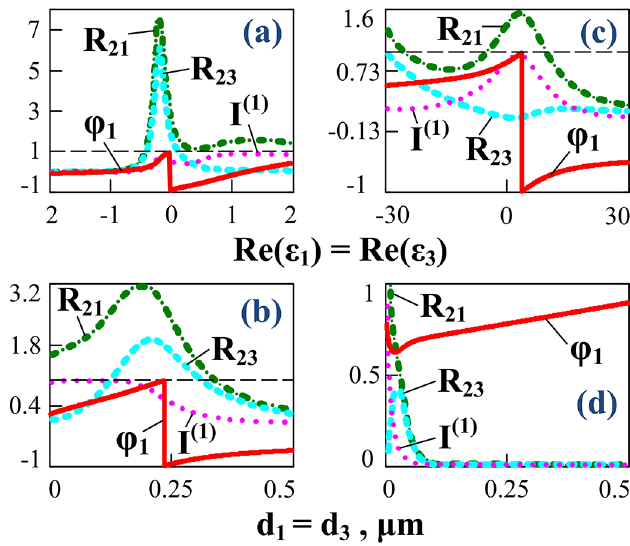
Fig. 10. Dependences of quantities ’ 1 , R 21 , R 23 , I (1) on parameters e 0 (a, c), d 1,3 (b, d) for various materials of layers 1 ; 3 ¼ 0 : 01 (a, b), 0.5 (c, d); 1, 3. The values of parameters are: e 00 1 ; 3 e 0 ¼ 0 : 01 (b), (cid:1) 13 (d); d 2 = 39nm (a, b), 156 nm (c, d); 1 ; 3 d 1,3 =250 nm (a, b), 13nm (c, d); l =0.63 m m (a, b), 0.6 m m (c, d). I (1) = I TM (1) ( z = d 1 +0.5 d 2 ) for all the graphs. The black horizontal dashed line in fi gs. a, b, c characterizes equality to 1 of the corresponding